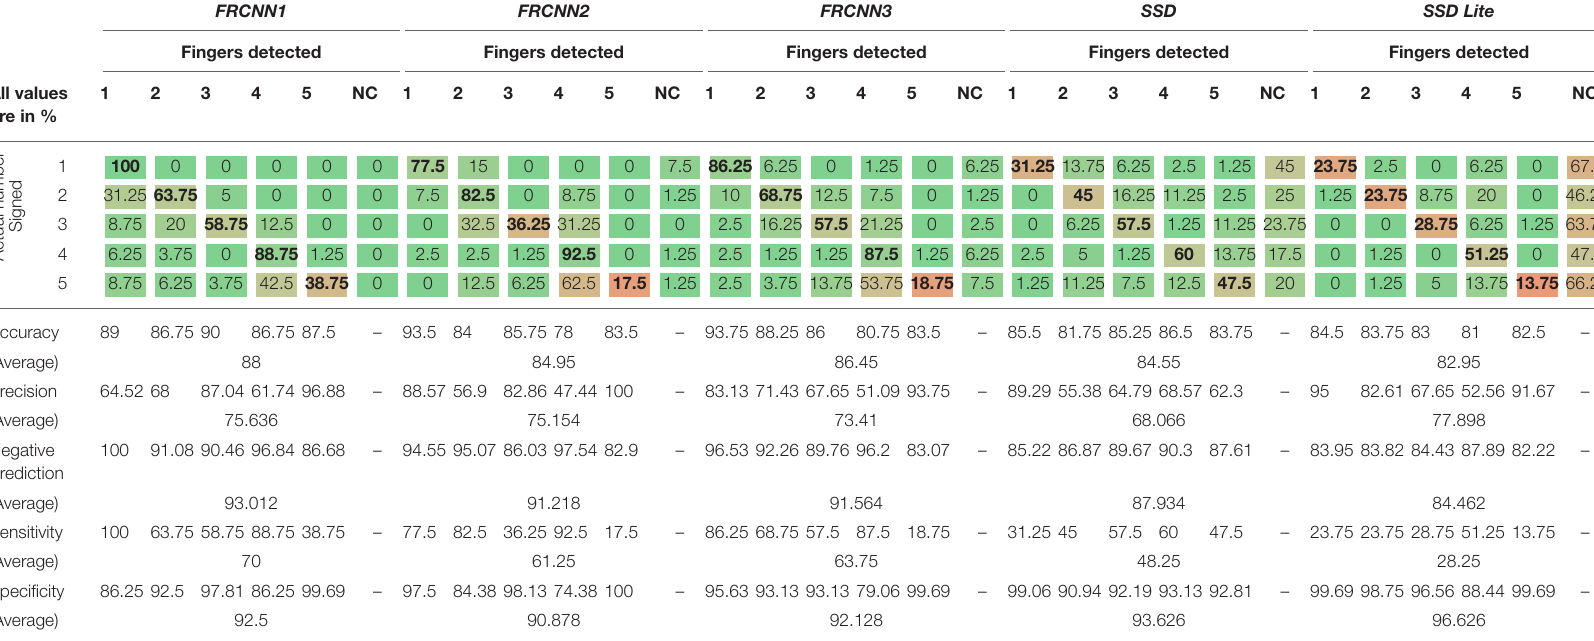
TABLE 4 | Results of the detection using the five example networks. FRCNN1 FRCNN2 FRCNN3 SSD SSD Lite Fingers detected Fingers detected Fingers detected Fingers detected Fingers